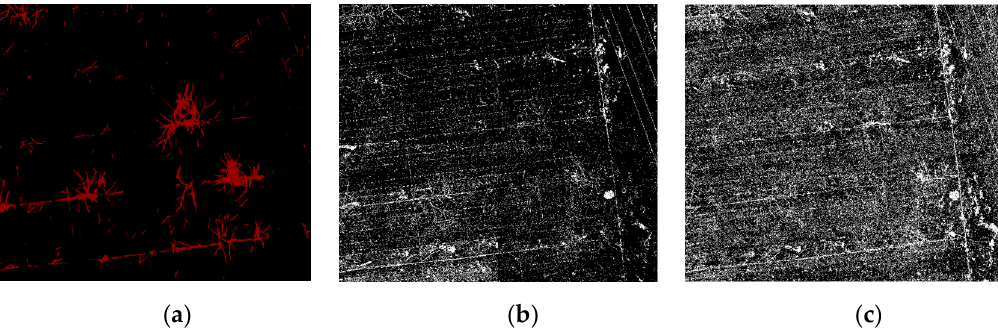
Figure 6. Classification effect picture under the different classification methods. As demonstrated, ( a ) is the result of the PSPnet classification, ( b ) is the result of the SVM classification, and ( c ) is the result of the RF classification.